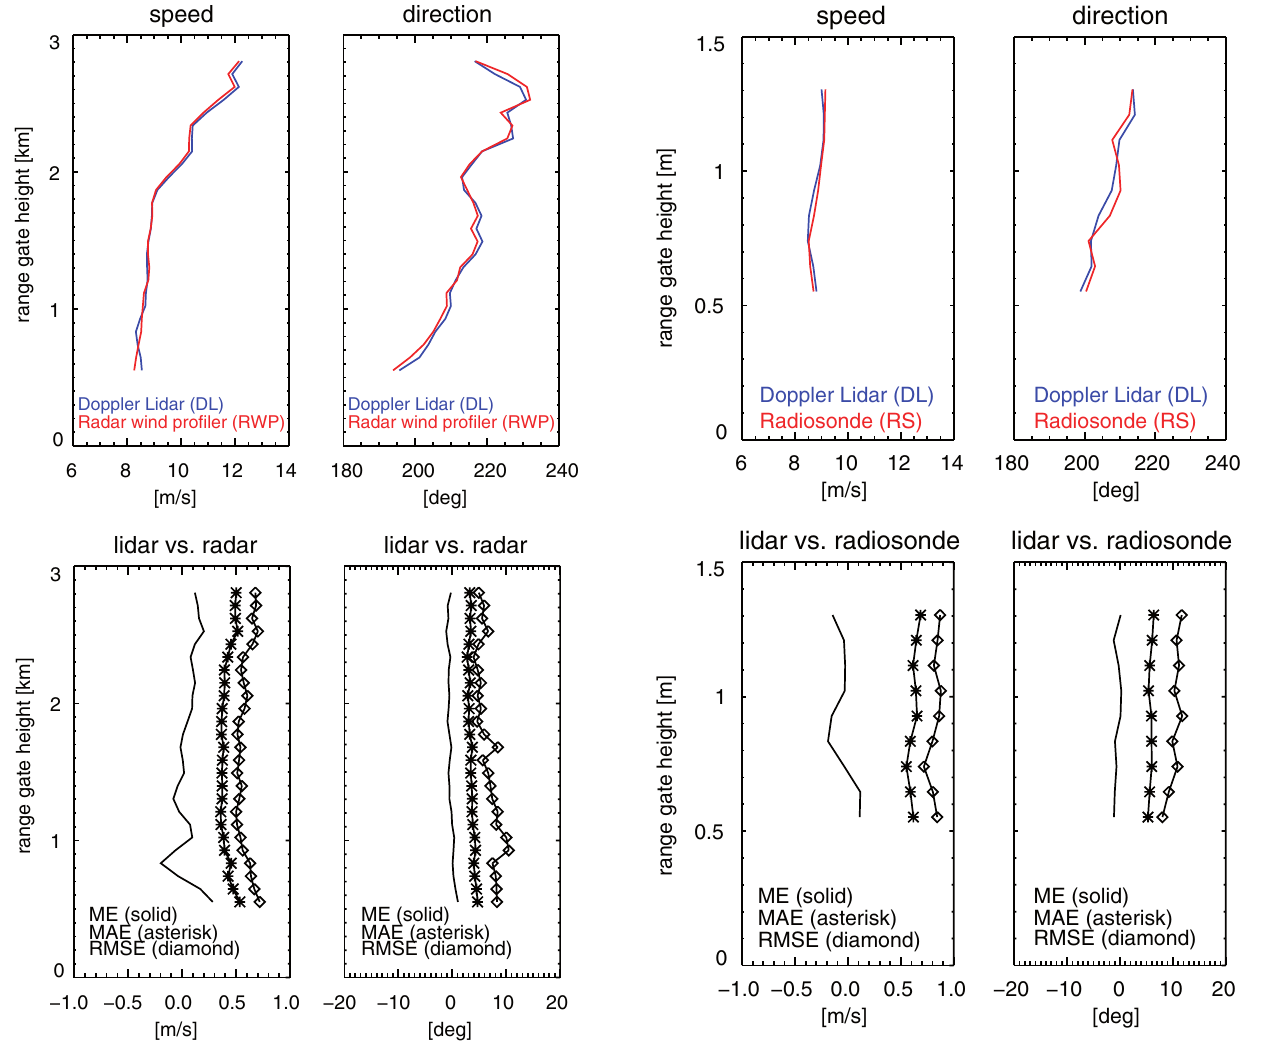
Figure 10. Statistical results of the DLWR comparison. The upper two panels show the annual mean of wind speed and direction ob- tained from Doppler lidar and wind profiler measurements, respec- tively. Error bars denoting the precision of the wind speeds in the annual profiles are not shown because of their very low magnitudes (see also the remarks in Sect. 3.1). The lower two panels show the respective verification scores ME (mean error), MAE (mean abso- lute errors) and RMSE (root mean squared error).